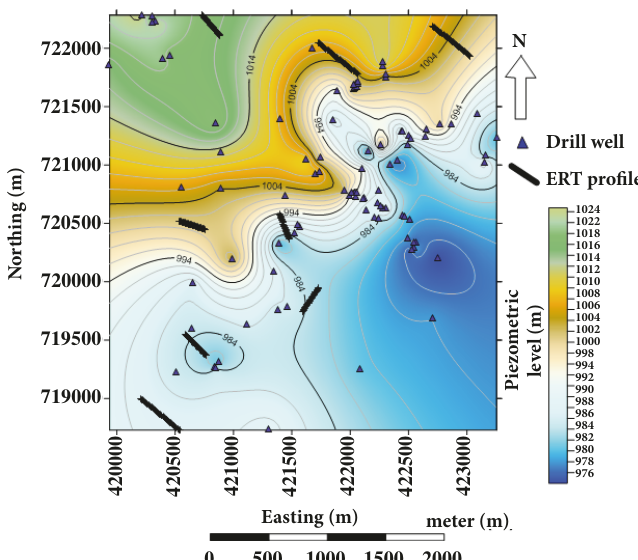
Figure 20: Groundwater head map of the study area.